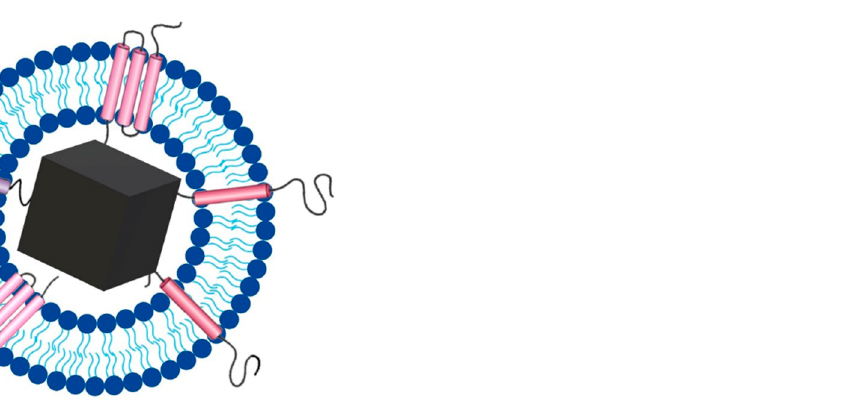
Figure 1. The schematic representation of a magnetosome involves a lipidic membrane with embedded proteins and magnetite mineral inside.